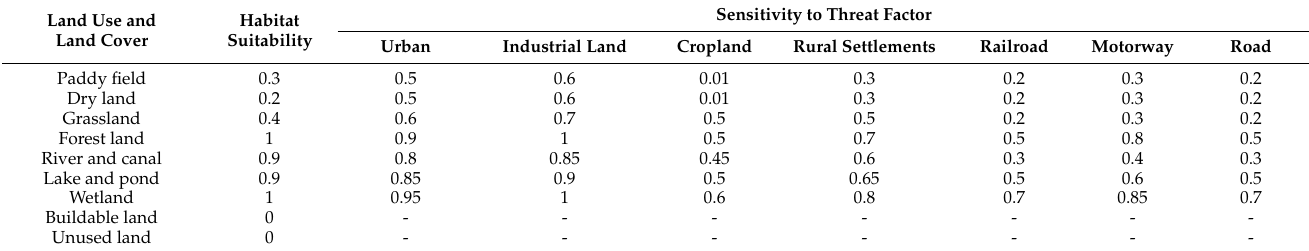
Table 2. The sensitivity of land use type to habitat threat